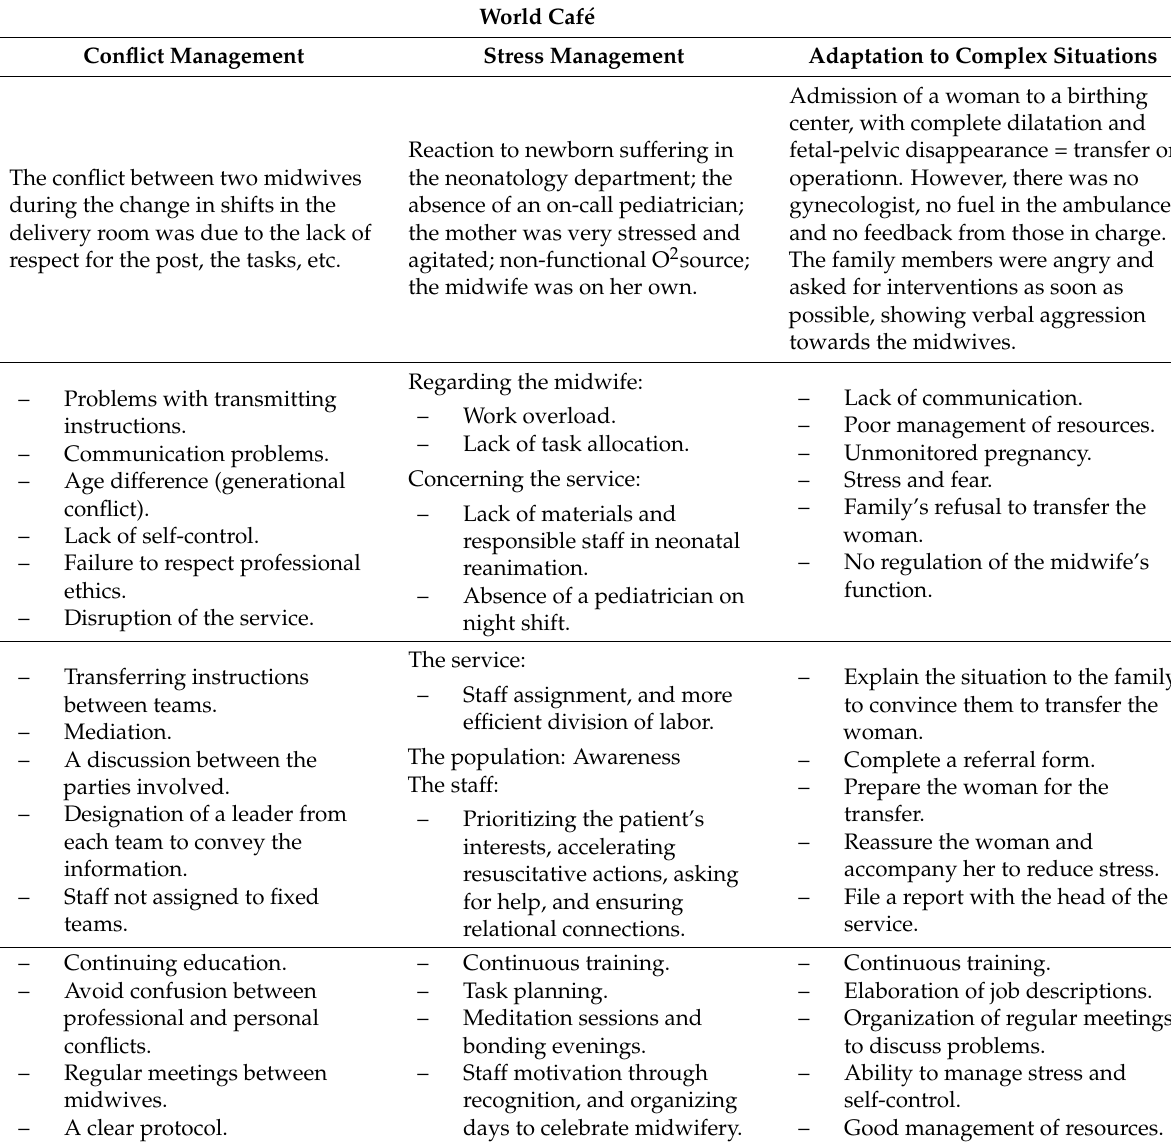
Table 3. The four cycles of the World Caf é protocol. World Caf